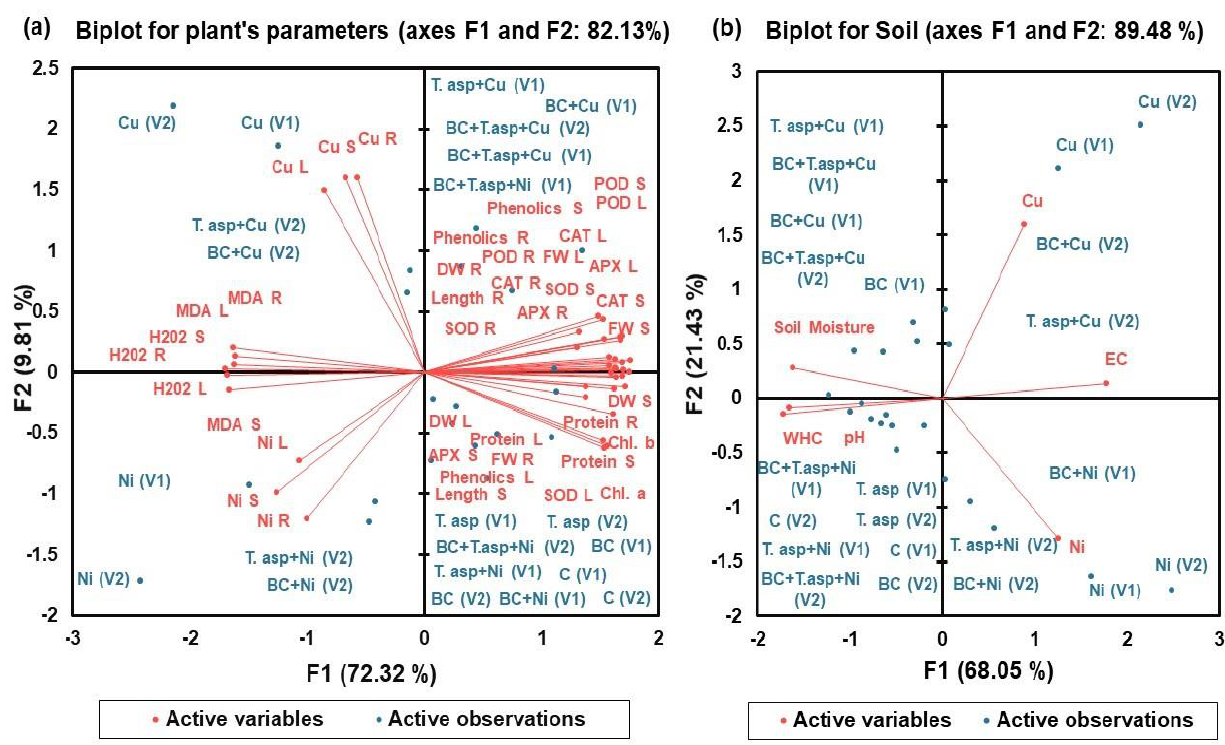
Figure 9. Principal component analysis (PCA) of two maize cultivars “spring corn” (V1) and “footer corn” (V2) and soil parameters. The two main factors of PCA (F1 and F2) significantly contributed to generate PCA biplots. Active variables are ( a ) Length, Fresh weight (FW), Dry weight (DW), Chlorophyll a (Chl. a), Chlorophyll b (Chl. b), Proteins, Phenolics, Hydrogen peroxide (H 2 O 2 ), Malondialdehyde (MDA), Ascorbate peroxidase (APX), Catalase (CAT), Superoxide Dismutase (SOD), Guaiacol peroxidase (POD), total Cu and total Ni and ( b ) parameters of soil such as Ph, EC, Soil Moisture%, Water Holding Capacity (WHC), total Cu and total Ni; however, R, S and L stand for root, stem and leaf, respectively. Active observations are control, Copper (Cu), Nickel (Ni), Trichoderma asperellum (T. asp) , simple Biochar (BC).